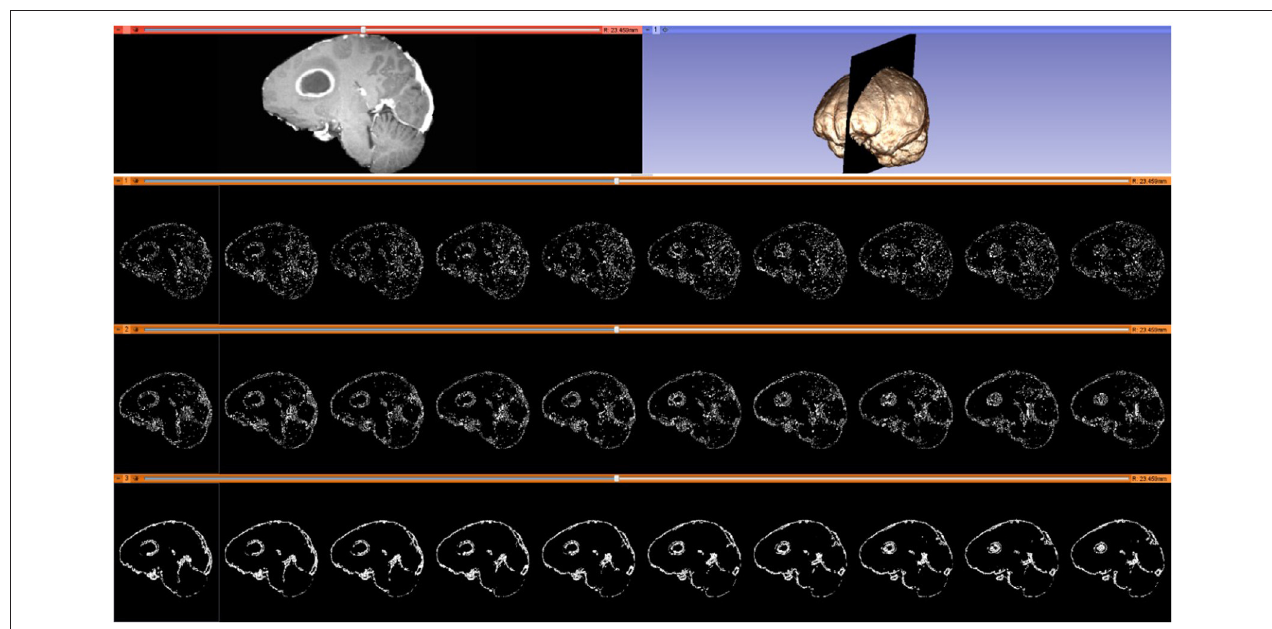
FIGURE 4 | Selected blocks from an MRI volume using various connectivity patterns. Blocks are depicted on 10 consecutive sagittal slices. From top to bottom row: sagittal slice (left) and volumetric MRI rendering (right); selected blocks with a “vertex” pattern; selected blocks with an “edge” pattern; selected blocks with a “face” pattern. Number of selected blocks for all patterns: 322,060.